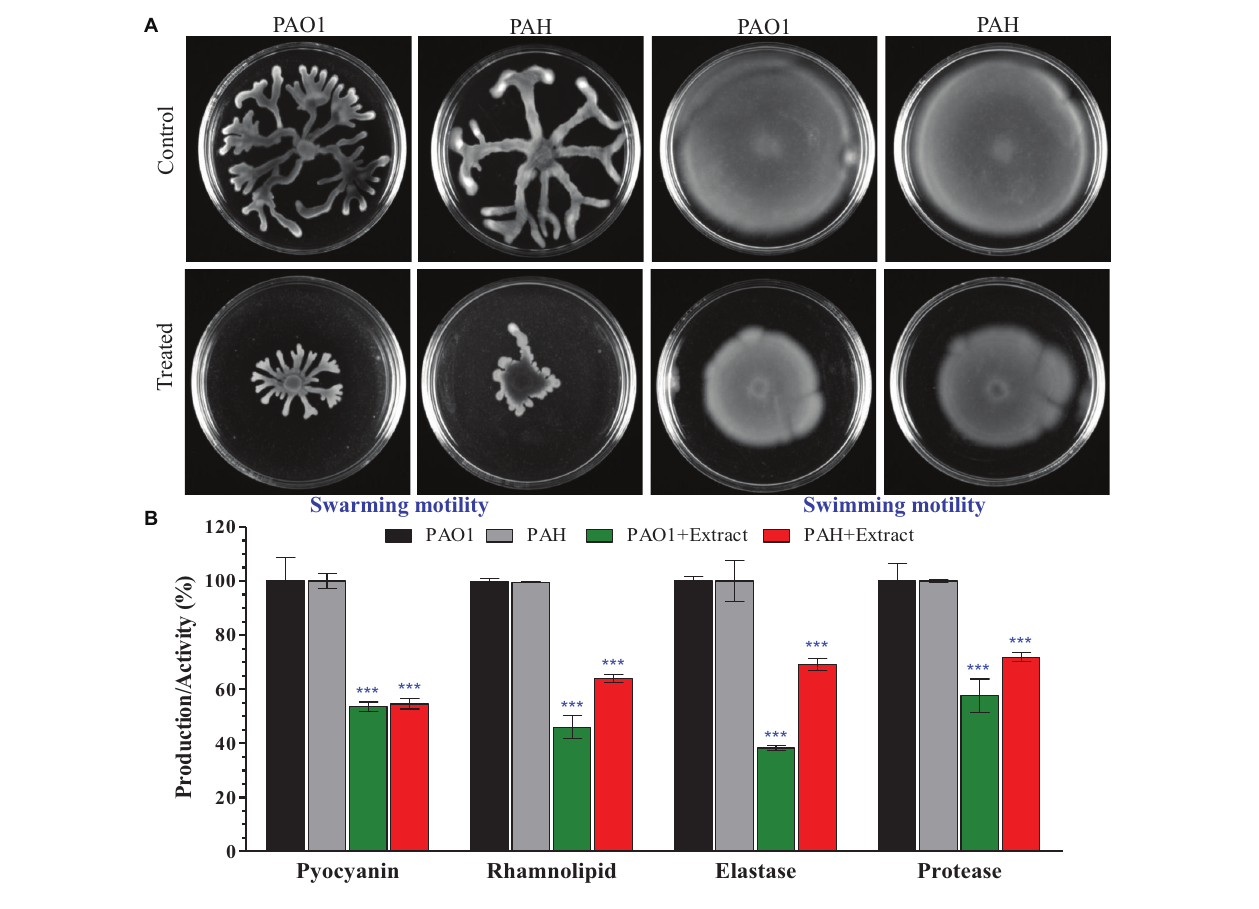
FIGURE 5 | Effect of E. indicum SJ16 extract on cell motility, and the virulence factors of P. aeruginosa . (A) The effect of the bacterial extract on the swarming and swimming motility of reference P. aeruginosa strains (PAO1 and PAH). P. aeruginosa was spotted on a plate supplemented with 1.0 mg/ml extract or without extract supplementation (control). Plates were analyzed after incubation of 24 h at 37 ◦ C; (B) The effect of the bacterial extracts (SJ16; 1.0 mg/ml) was determined based on the production of virulence factors of the reference P. aeruginosa strains by quantifying pyocyanin and rhamnolipid, as well as by analyzing the elastase and protease activities. “ ∗∗∗ ” Indicates significant differences from the control at P <